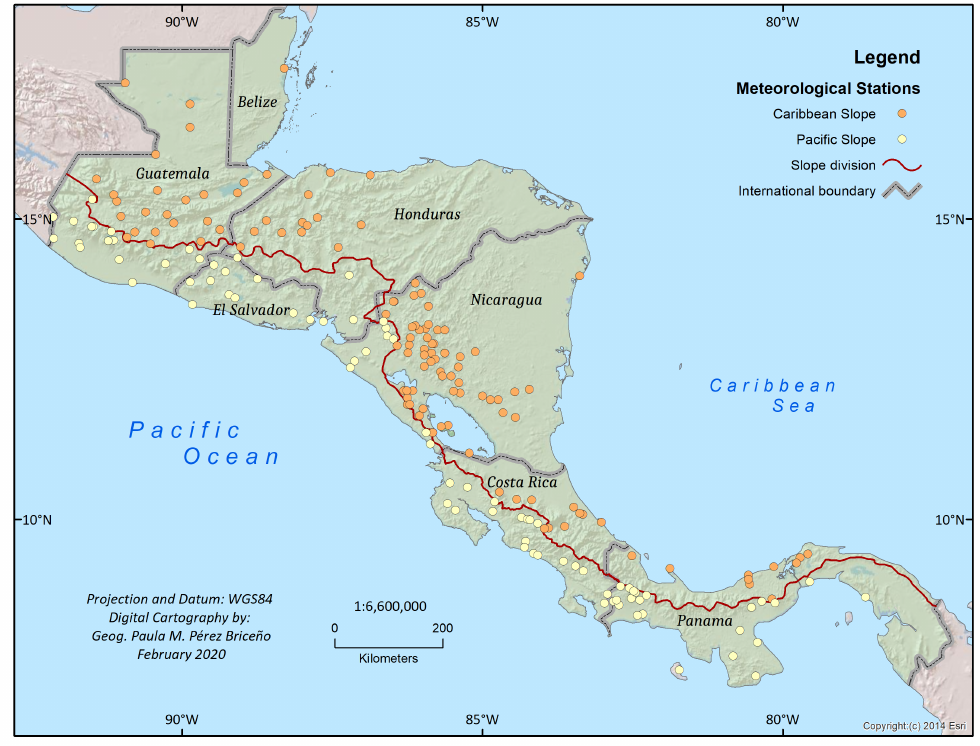
Figure 1. Location for 199 meteorological stations in the Central American Region. Yellow and orange dots are gauge stations located in the Pacific and Caribbean slope,